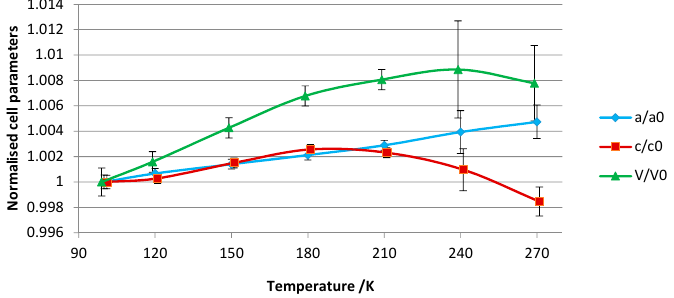
Figure 5. The evolution of the normalised unit-cell parameters as function of temperature (errors at 3 σ level) taken from the structures in Supplementary Table S1, see Supplementary Information for details.